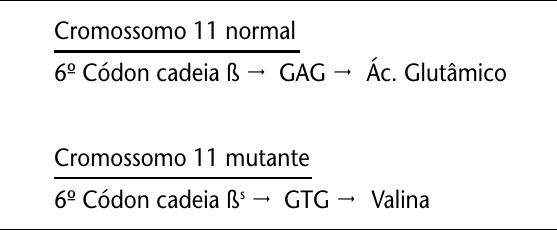
Figura 1 – Representação esquemática da mutação gênica responsável pelo surgimento da Hb S